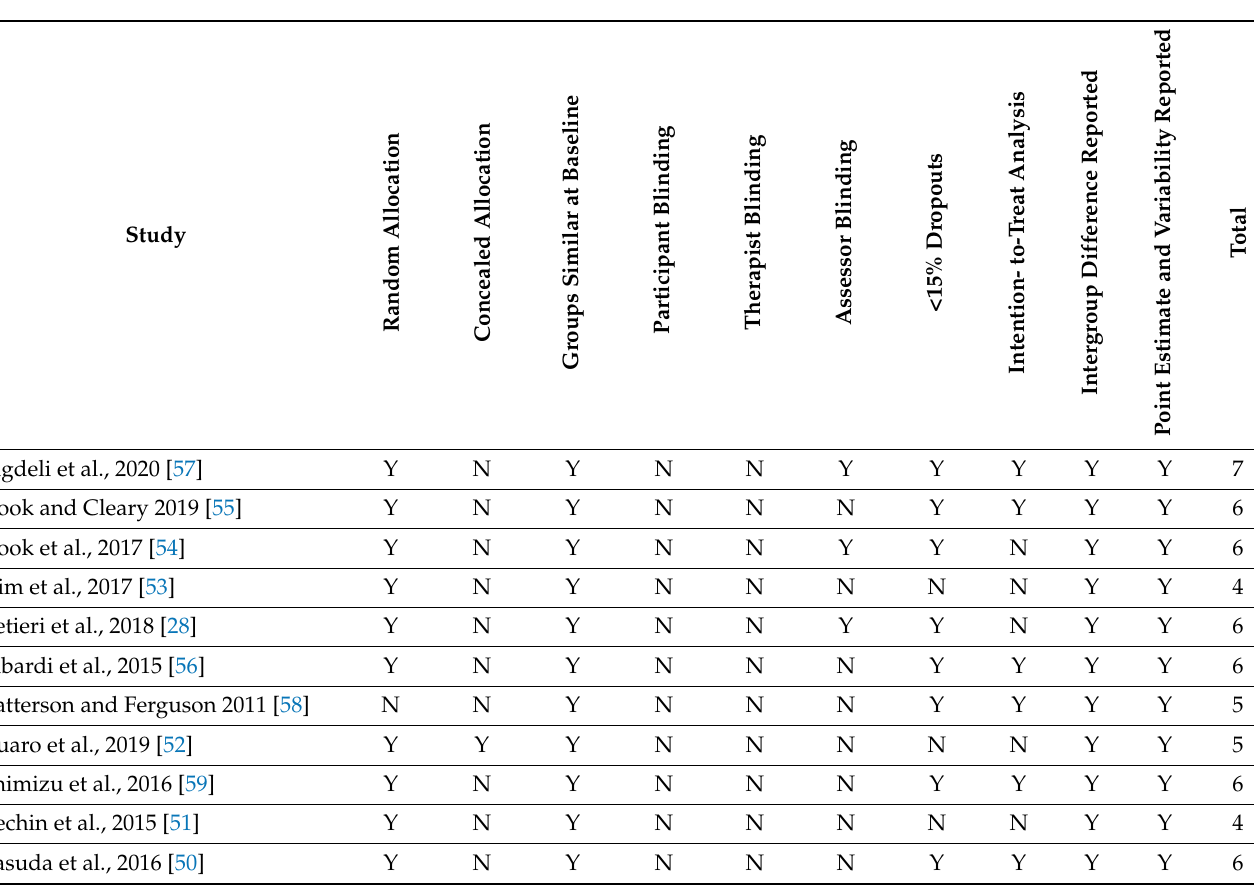
Table 2. PEDro scores for included studies (n =